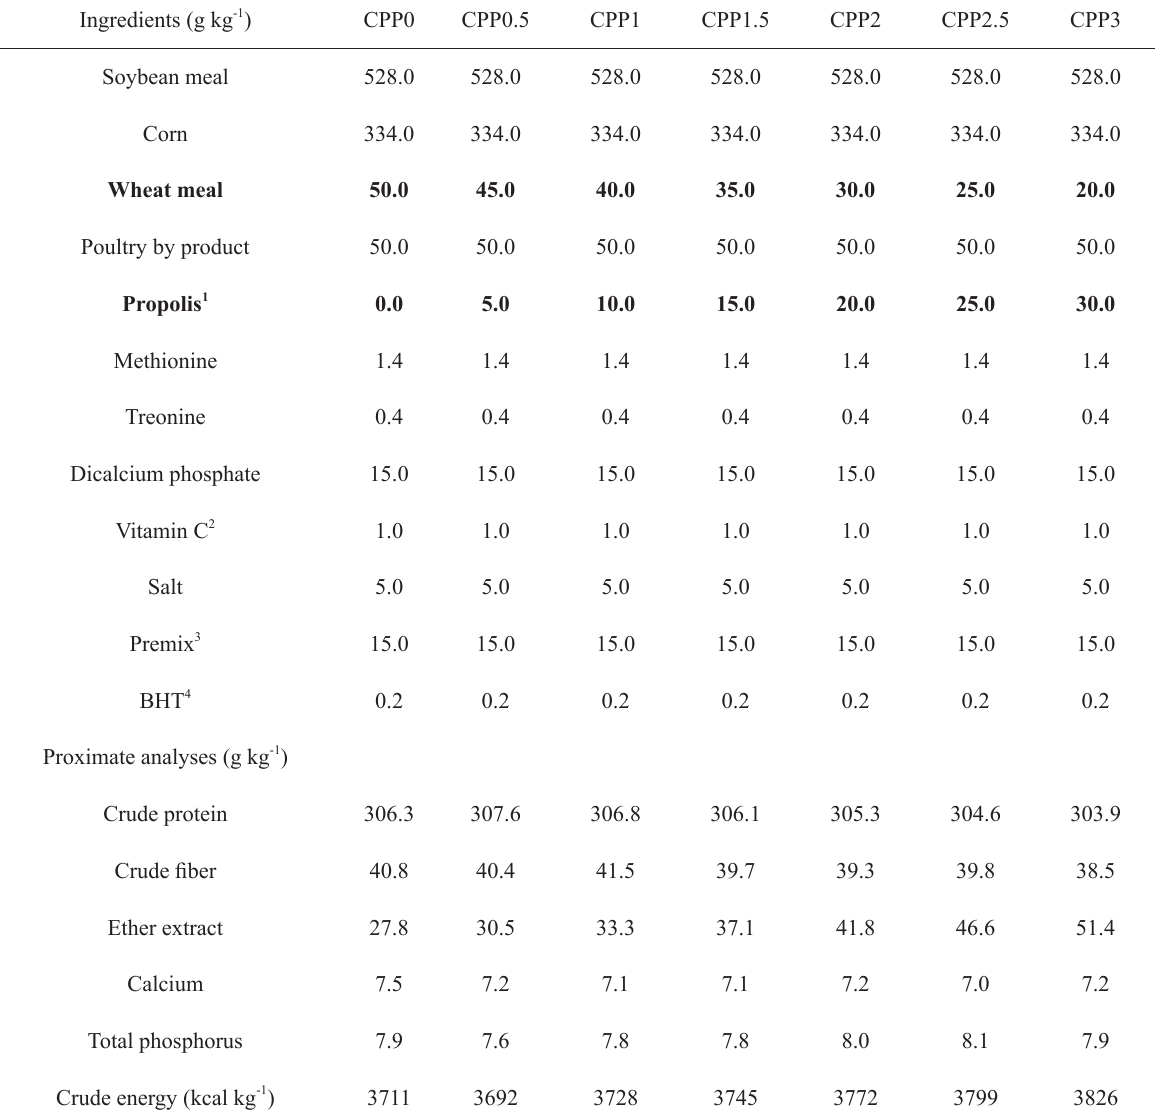
Formulation and proximate chemical composition of the experimental